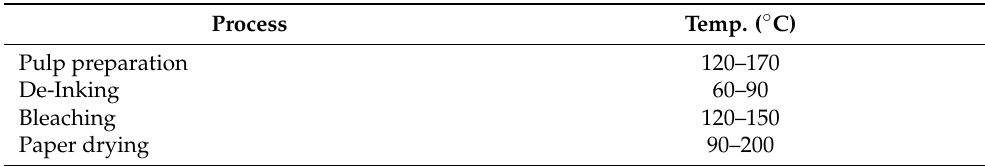
Table 4. Paper industry process [99,100].